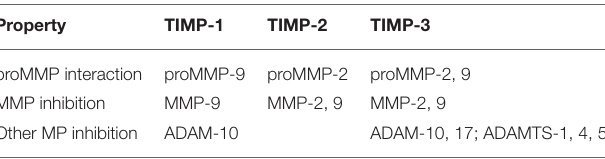
TABLE 4 | Summary of inhibition relationships between the selected TIMPs and MPs in the present study.